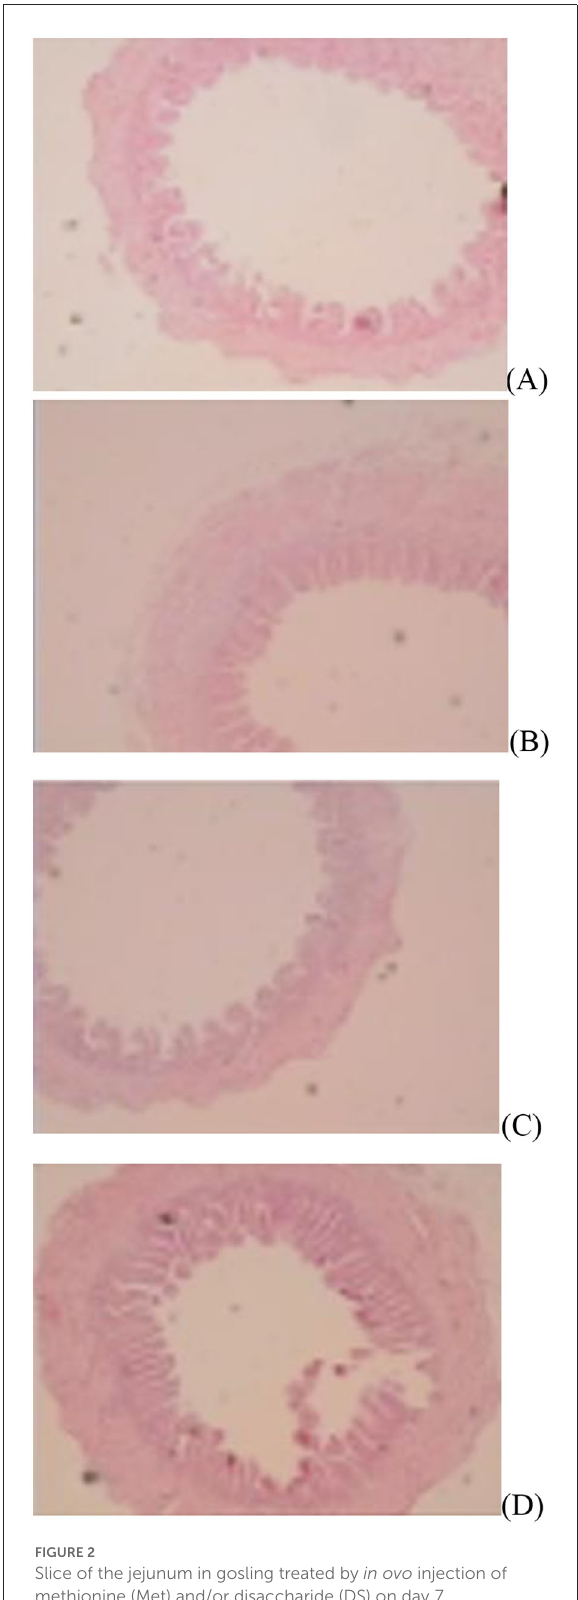
FIGURE1 Slice of the jejunum in gosling treated by in ovo injection of methionine (Met) and/or disaccharide (DS) on day of hatching. (A) Non-injection group; (B) DS injection group; (C) Met injection group and (D) DS plus Met injection group.